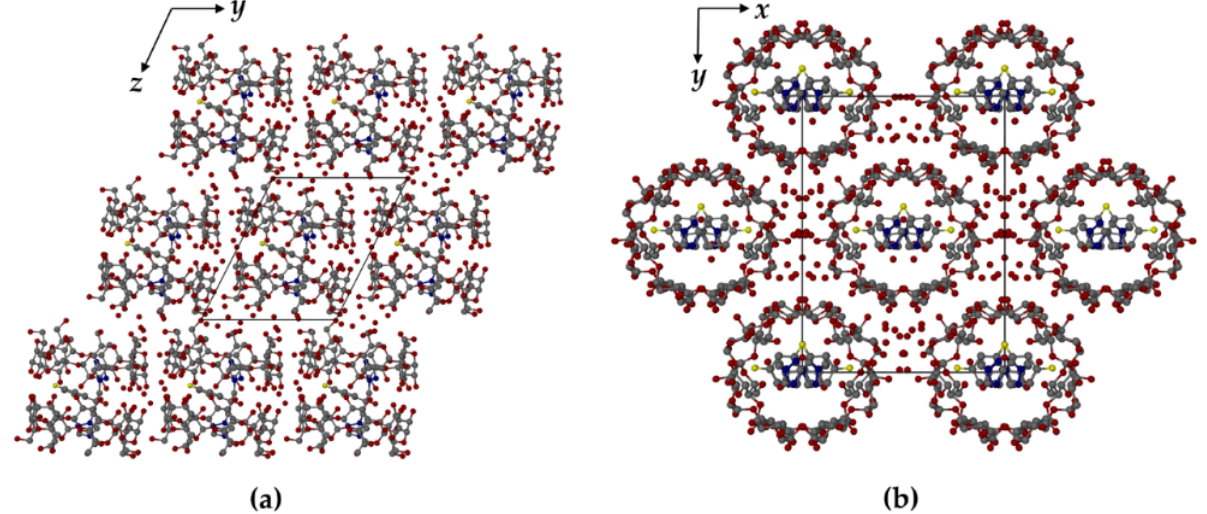
Figure 5. Crystal packing arrangements in TBCDFLU, (100) projection ( a ) and MBCDFLU, (001) projection ( b ). For clarity, no H atoms are included. Water oxygen atoms are shown as isolated red spheres. The C-centered arrangement of the complex units in ( b ) is evident.